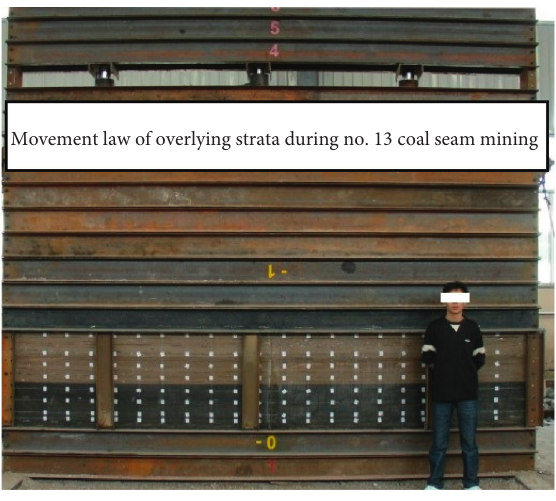
Figure 1: Photo panorama of the entire